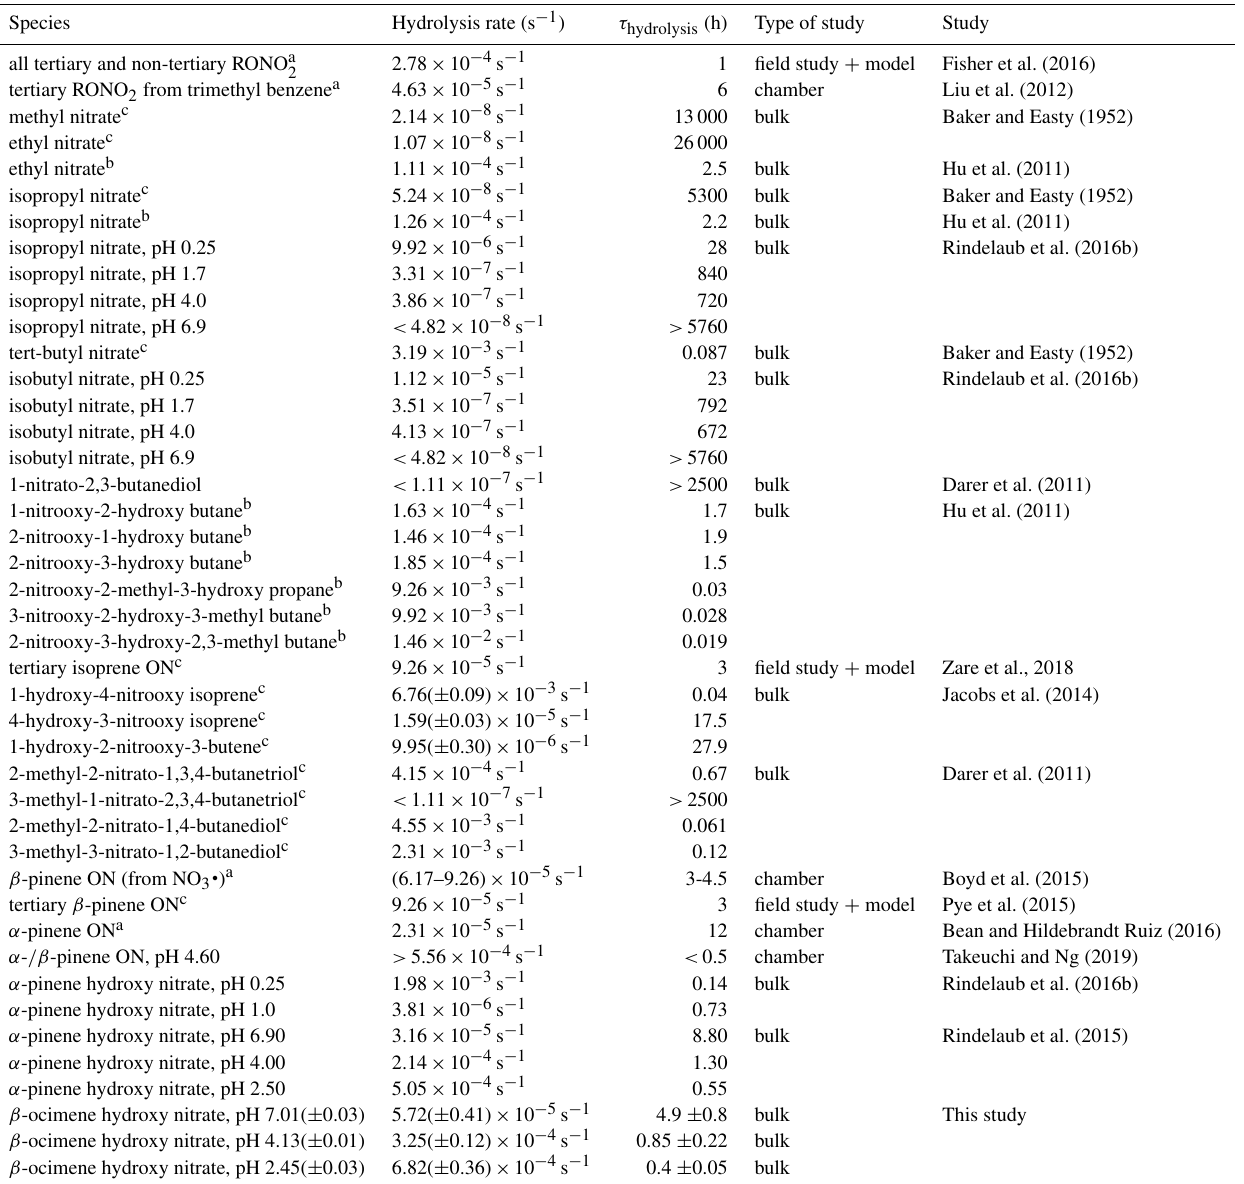
Table 3. Hydrolysis rate constants and lifetimes reported in the literature. Species Hydrolysis rate (s − 1 ) τ hydrolysis (h) Type of study Study all tertiary and non-tertiary RONO a